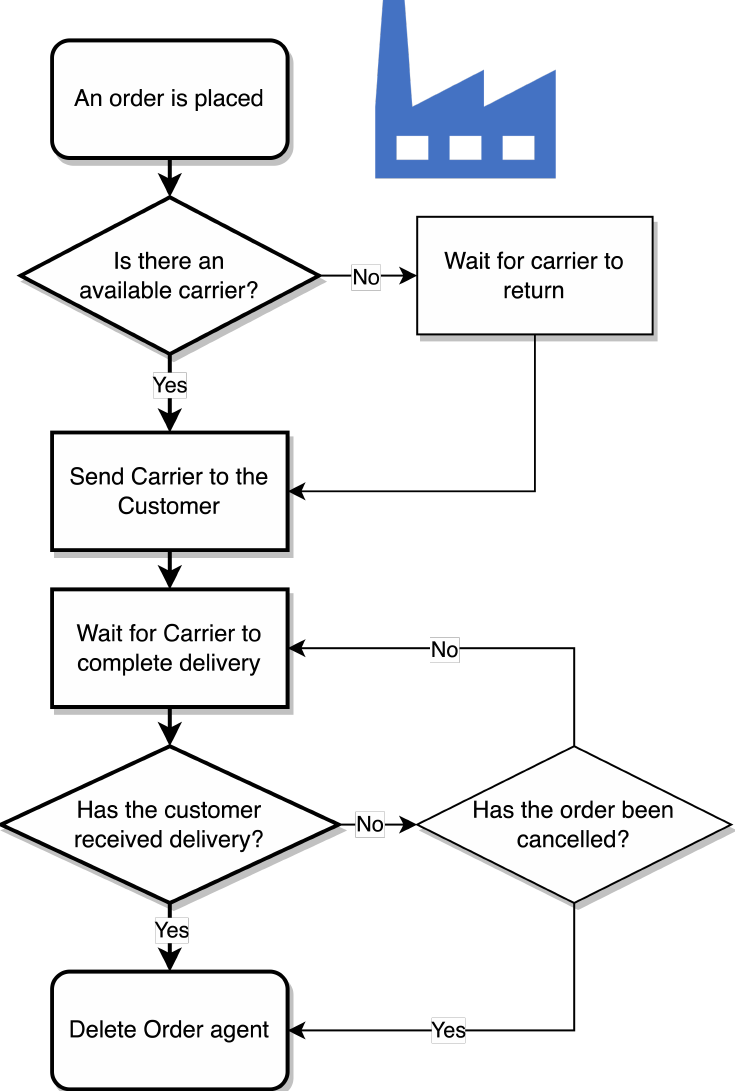
Figure 5. Supplier agent